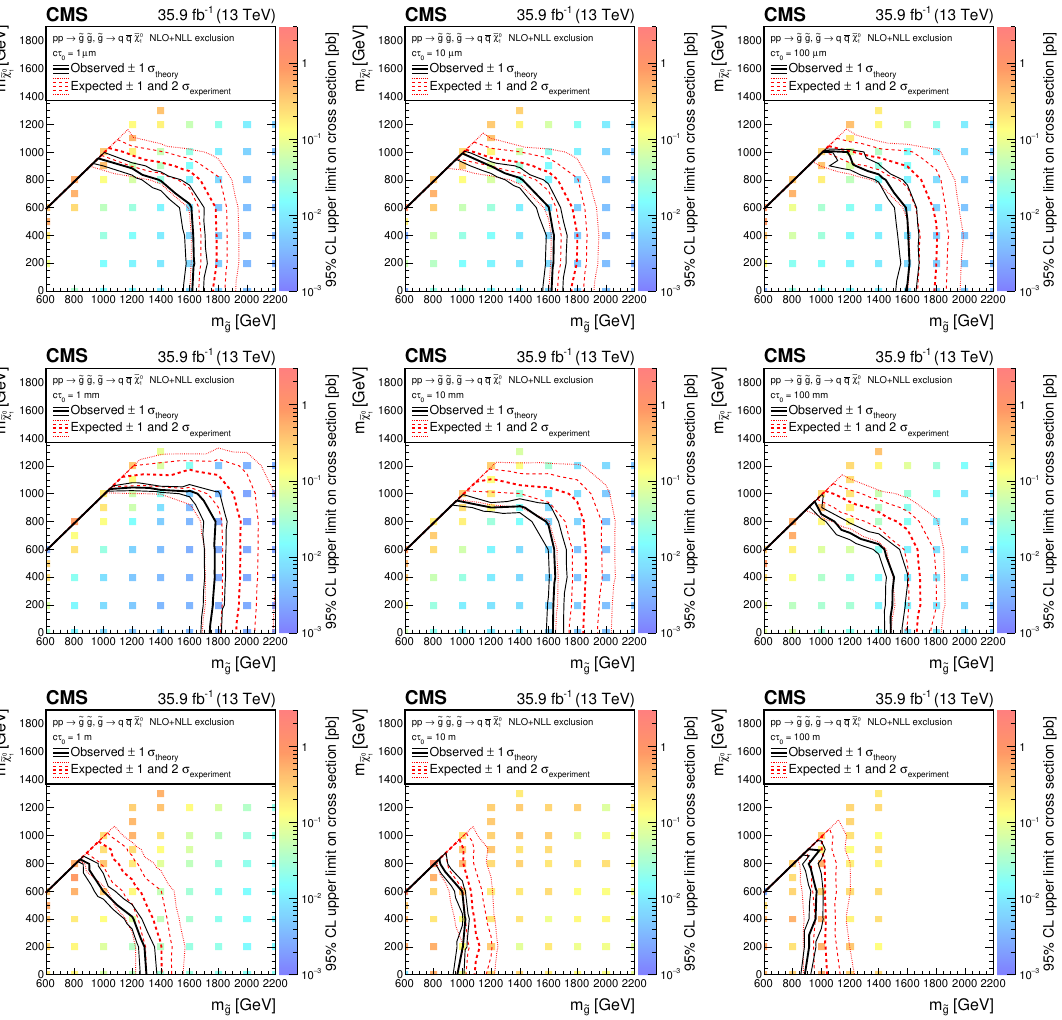
Figure 4 . Observed upper limit in cross section at 95% CL (indicated by the colour scale) as a function of the g and (cid:31) 0 masses for simpli(cid:12)ed models that assume the production of pairs of e e 1 long-lived gluinos that each decay via highly virtual light-(cid:13)avour squarks to the neutralino and SM particles (T1qqqqLL). Each sub(cid:12)gure represents a di(cid:11)erent gluino lifetime: c(cid:28) 0 = 1 (upper left), 10 (upper centre), and 100 (cid:22) m (upper right); 1 (middle left), 10 (middle centre), and 100 mm (middle right); and 1 (lower left), 10 (lower centre), and 100 m (lower right). The thick (thin) black solid line indicates the observed excluded region assuming the nominal ( (cid:6) 1 standard deviation in theoretical uncertainty) production cross section. The red thick dashed (thin dashed and dotted) line indicates the median ( (cid:6) 1 and 2 standard deviations in experimental uncertainty) expected excluded